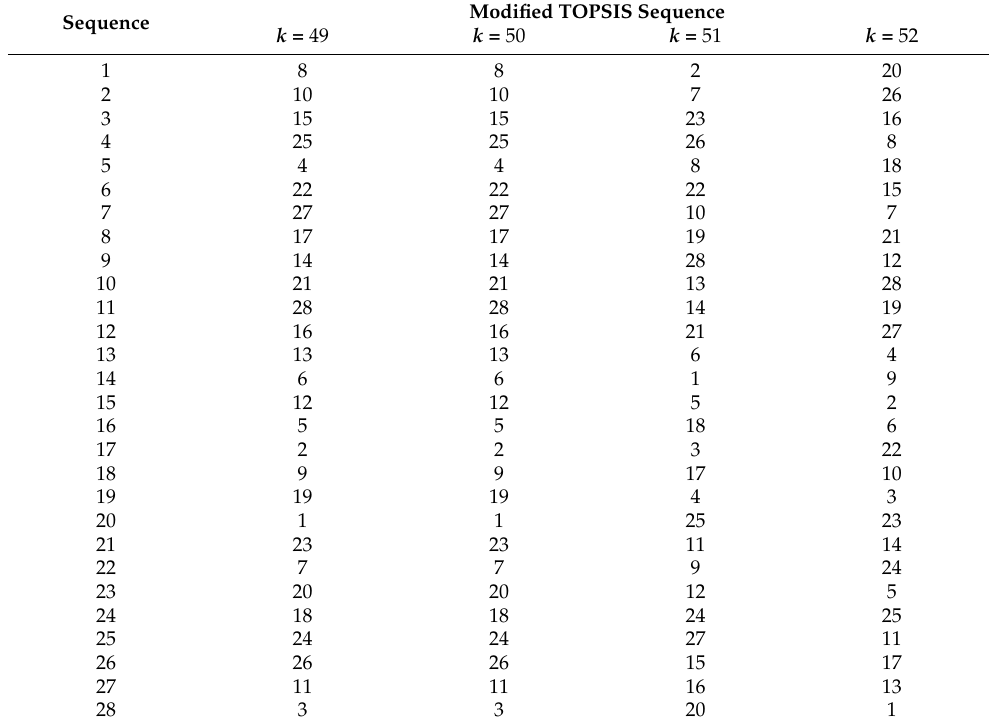
Table 4. Sequence of DGs in cluster 1.